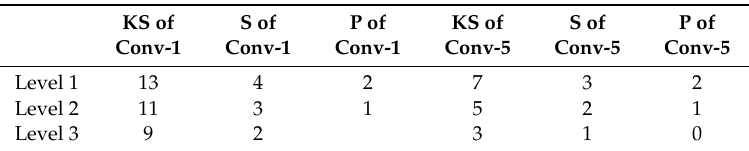
Figure 5. Computational Intelligence Application (CIA) data set. Table 3. Control factors and